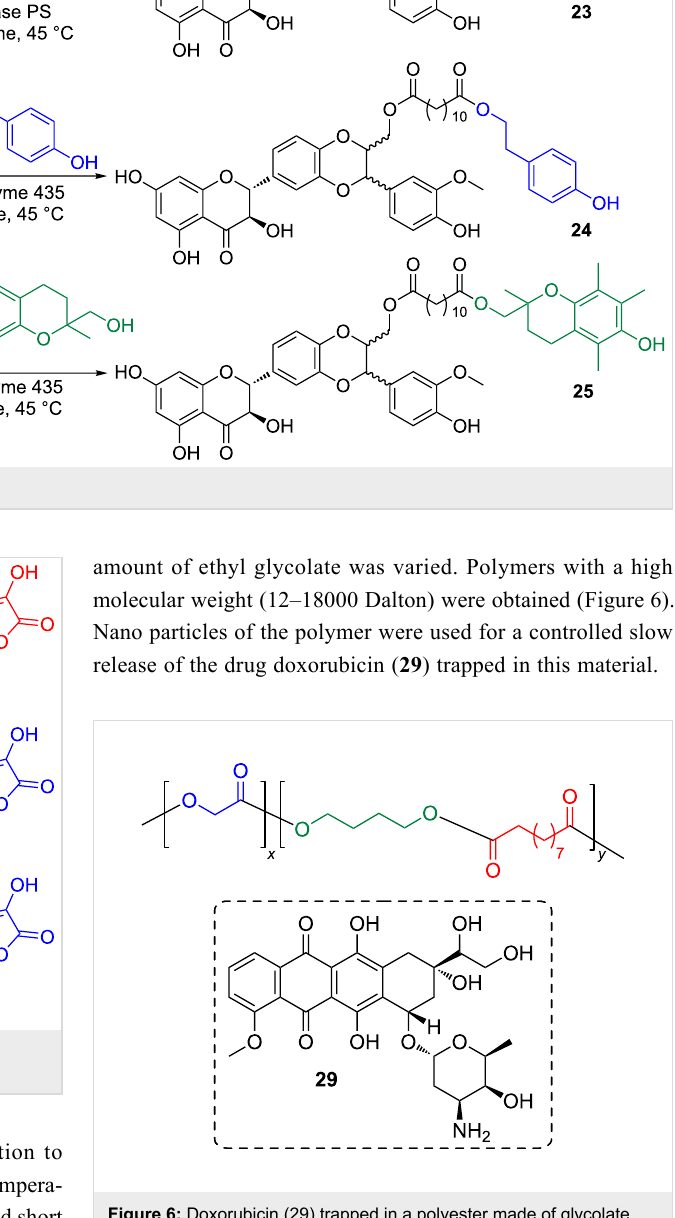
Figure 6: Doxorubicin (29) trapped in a polyester made of glycolate, sebacate and 1,4-butandiol units. Bhatia et al. used Novozyme 435 to make polymers from func- tionalized pentofuranose derivatives (i.e, 30 ) and PEG-600 dicarboxylic acid dimethyl ester [56]. The obtained polymers formed supramolecular aggregates with diameters between 120 and 250 nm, which were able to encapsulate Nile red ( 31 ) that was used as a model of a drug compound (Figure